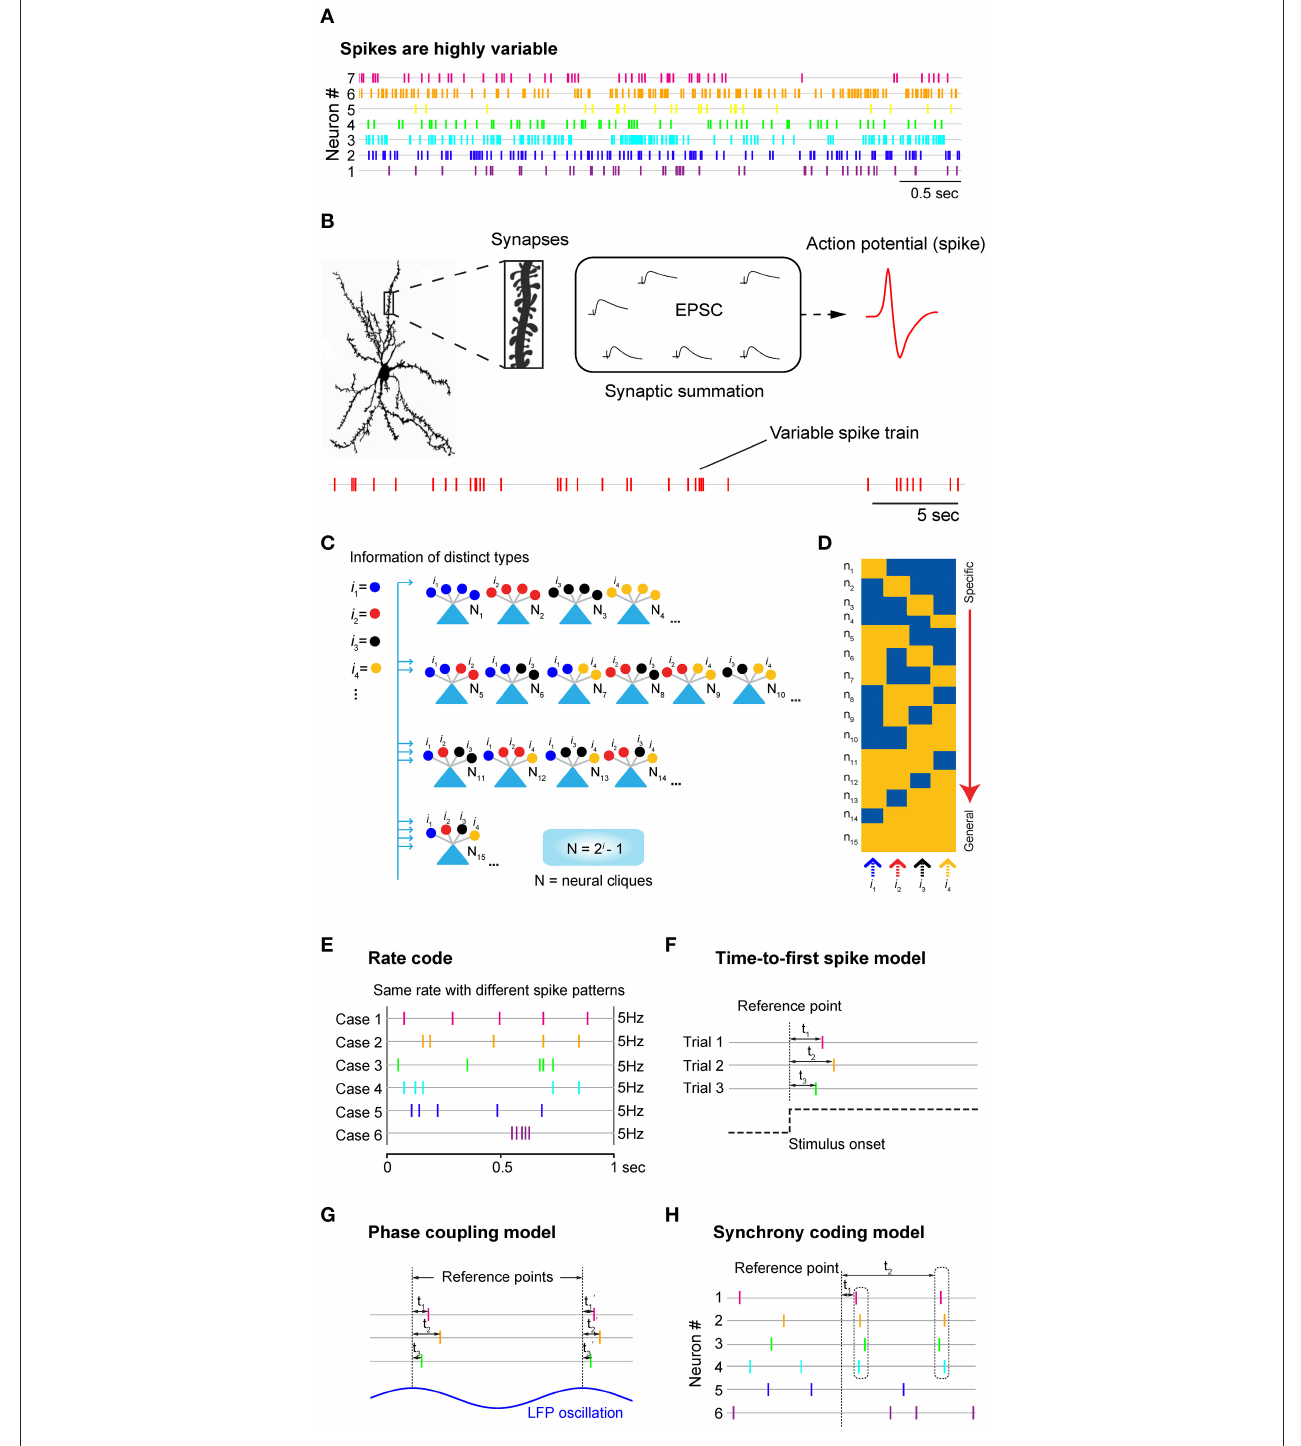
FIGURE 1 | Neuronal variability, underlying logic at synaptic and cell-assembly levels, and the traditional neural coding models. (A) Neurons discharge spikes all the time with enormous variability. Spike trains shown here are simultaneously recorded seven units from mice prefrontal cortex during animal’s quiet-awake period using tetrodes. (B) A cortical neuron may contain tens of thousands of synapses which can contribute to changes in excitatory postsynaptic potential (EPSP), leading to the generation of action potential or spike at the soma. Stochastic nature of synaptic patterns leads to highly variable spike trains in both the resting “control” condition and stimulus-presentation experiments. (C) Power-of-two-based Cell-Assembly Wiring Logic as the brain’s basic functional computational motif (FCM). A schematic